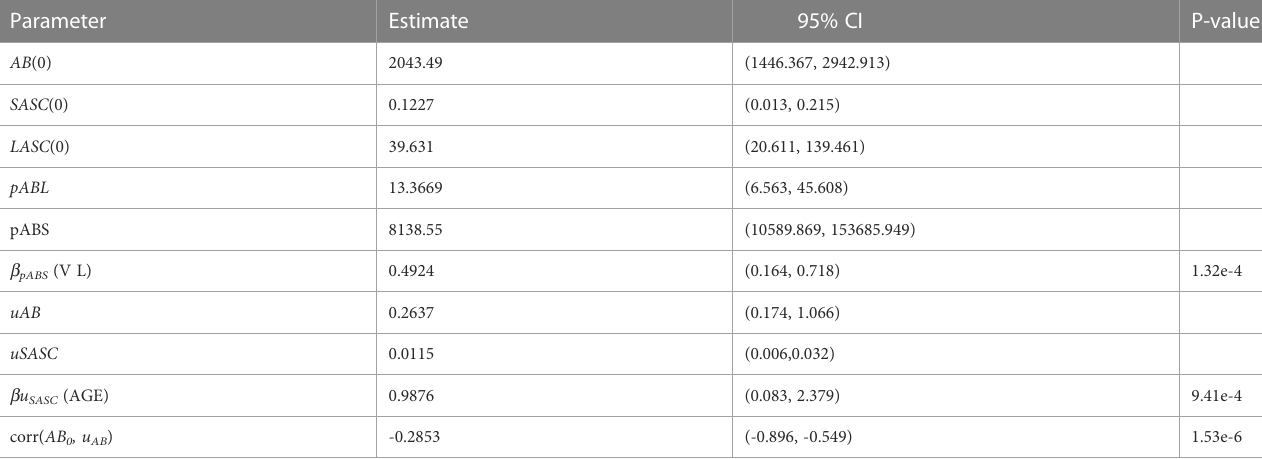
TABLE 2 Parameter estimates and corresponding 95% con fi dence intervals (CI) of fi nal model 6. Parameter